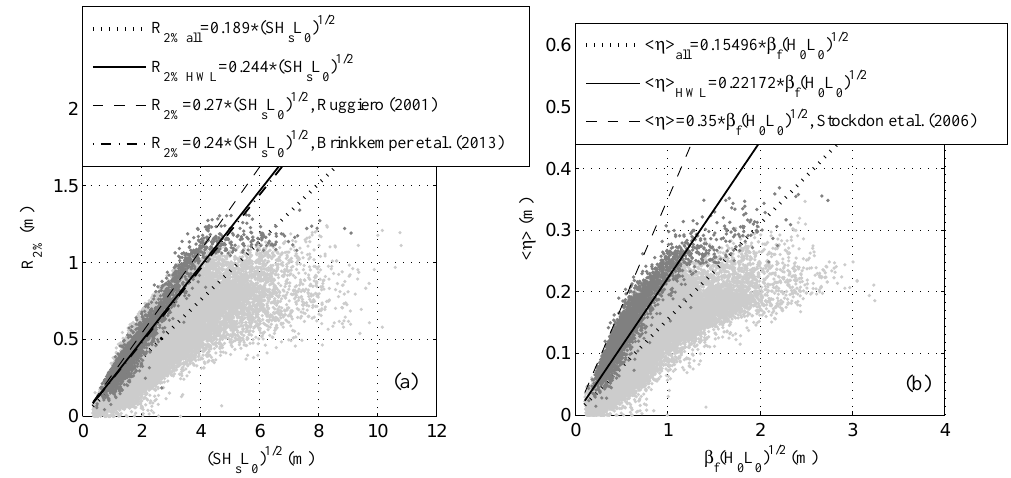
Figure 8. Linear fit to (a) R 2% values associated with high water level ( Z ≥ Z 5% = 0.32m, darker gray dots) and comparison to Ruggiero et al. (2001) and Brinkkemper et al. (2013) parameterizations; (b) setup values (all and high water levels) compared to Stockdon et al. (2006) parameterization. The dotted line corresponds to the linear fit performed to the entire set of data.